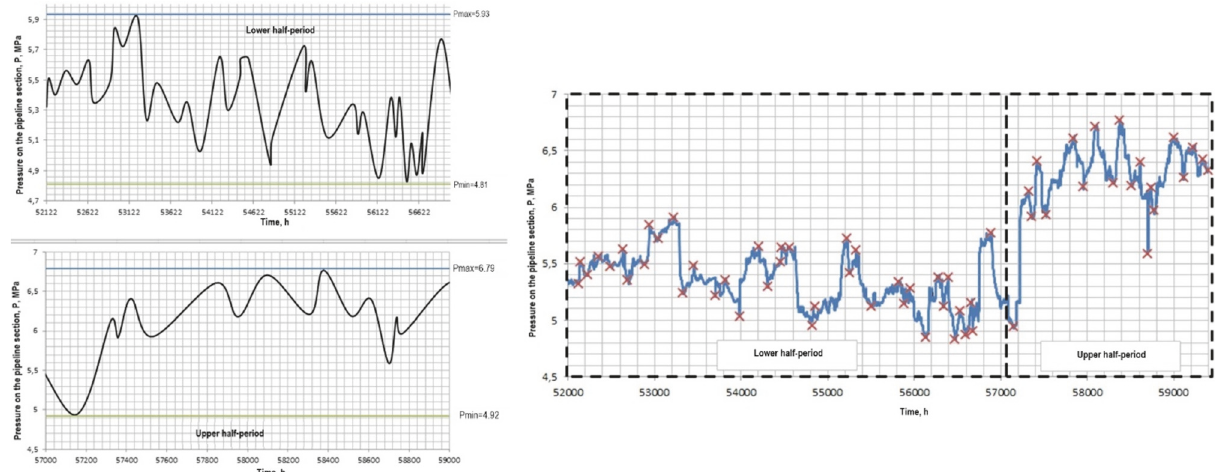
Figure 3: The upper and lower half-cycles of the oscillations in the chosen time interval